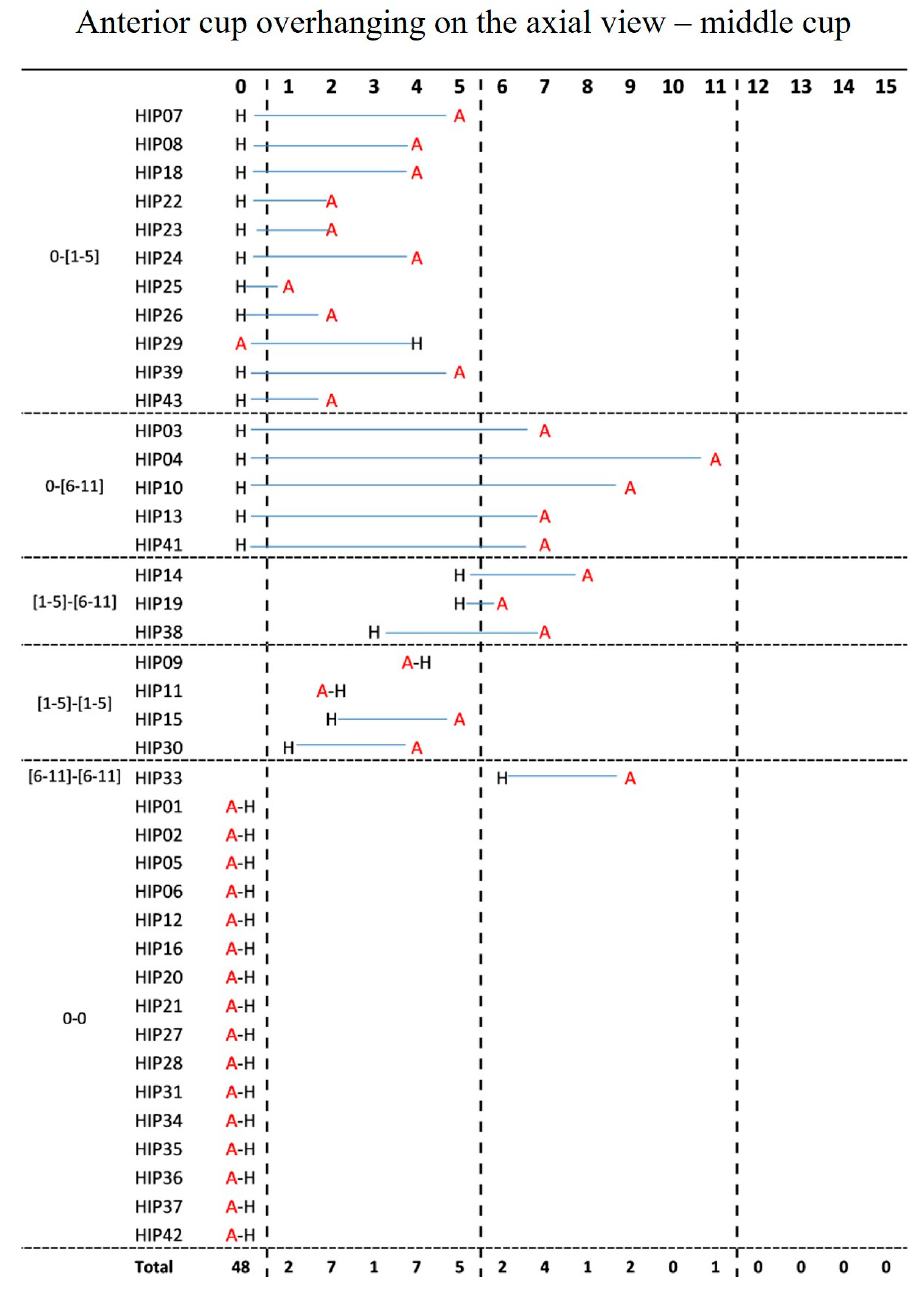
Figure 4. Anterior cup overhanging on the axial view at the center of the cup in the same case according to the two configurations AHCR (A) and HHCR (H).